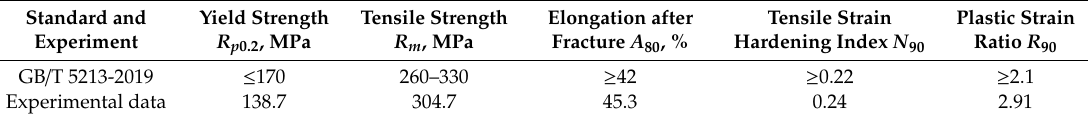
Table 3. Mechanical properties of DC06 IF steel.